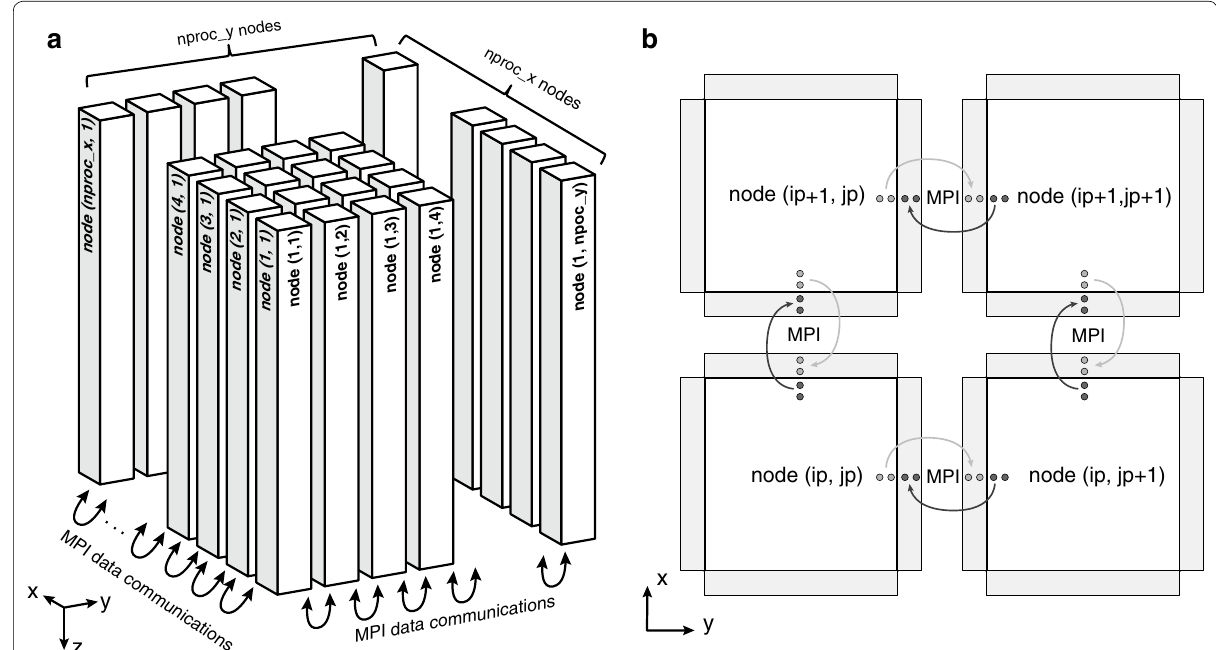
Fig. 5 a A schematic illustration of the domain partition model for MPI data communication in a 3D simulation. b A schematic illustration of the data communication strategy using MPI. (Reproduced from figure B1 of Maeda et al. (2013) with modification. Copyright by the Seismological Society of